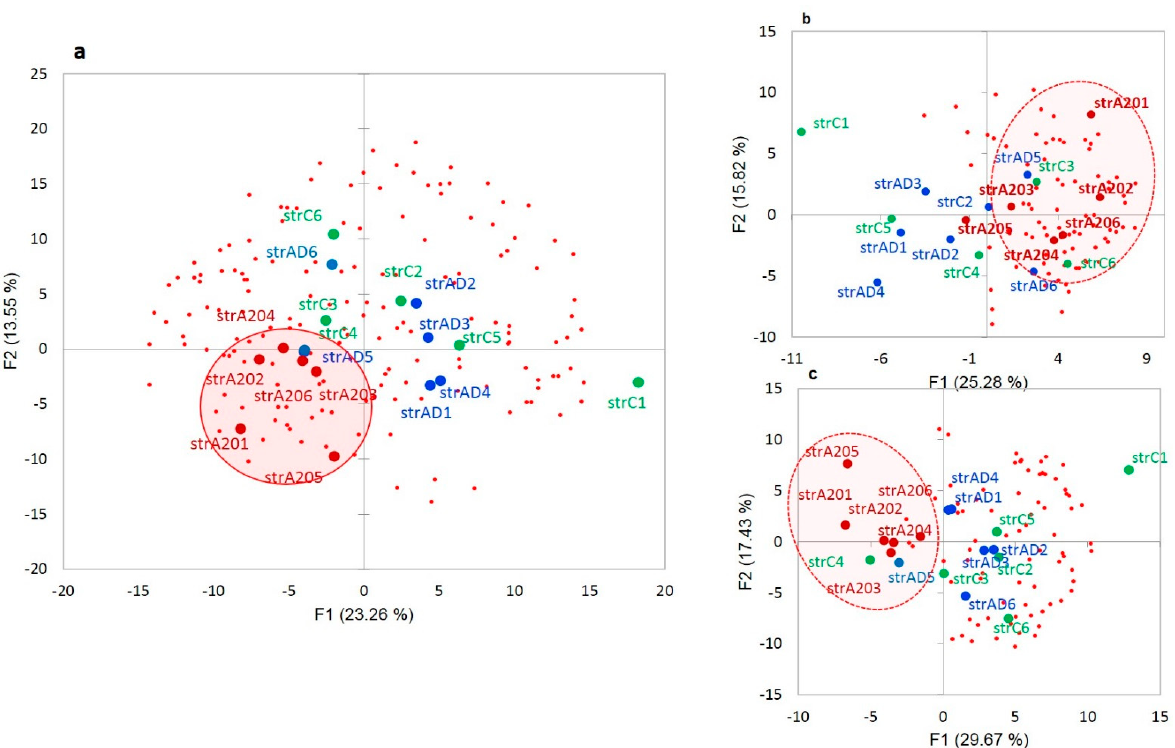
Figure 6. ( a ). PCA plot of the distribution of 163 merged DAS ES genes (Table S2e) based on their expression profiles. Red small dots denote the DAS genes; big red dots: AD20 group; blue dots: AD; and green dots: control. ( b ). Subset (from ( a ) genes) of 81 fold elevated A20-specific genes (Table S2g). ( c ). Subset (from ( a ) genes) 76 fold A20 negative genes (Table S2i). See GO annotation clusters ( b , c ) in Tables S2g,j, respectively. Clustering of the A20 group is systematically observed in each plot (encircled).